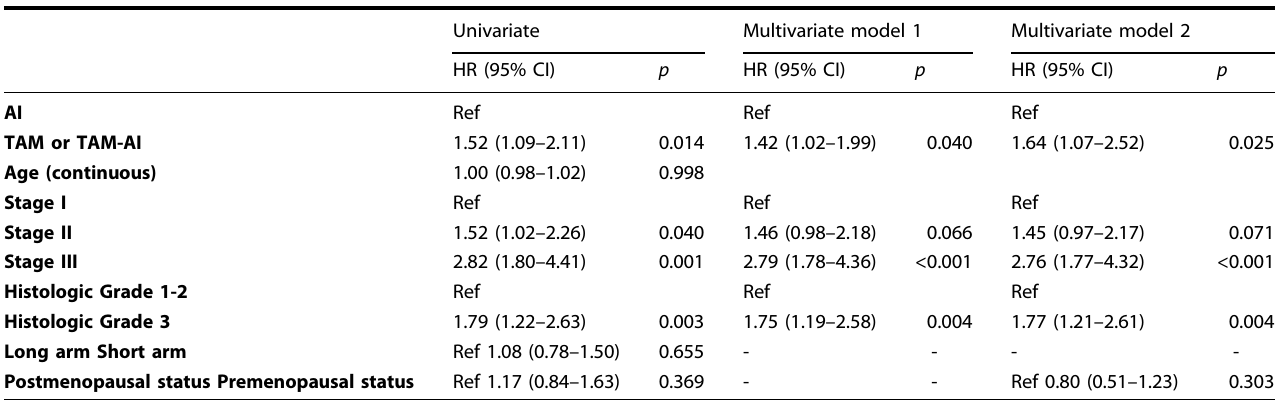
Table 3. Univariate and multivariate cox-regression models for